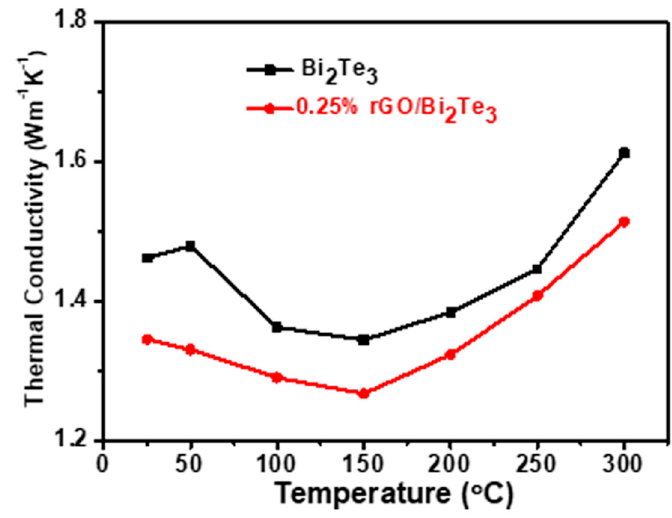
Figure 8. The thermal conductivity ( κ ) of Bi 2 Te 3 bulk materials and rGO / Bi 2 Te 3 nanocomposite bulk materials with 0.25 wt% rGO (parallel to the hot-pressing sintering direction).